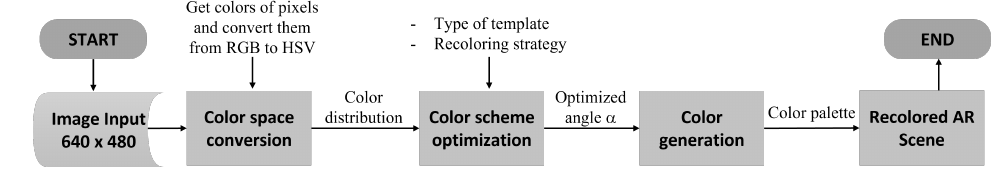
Figure 1. The workflow of the proposed